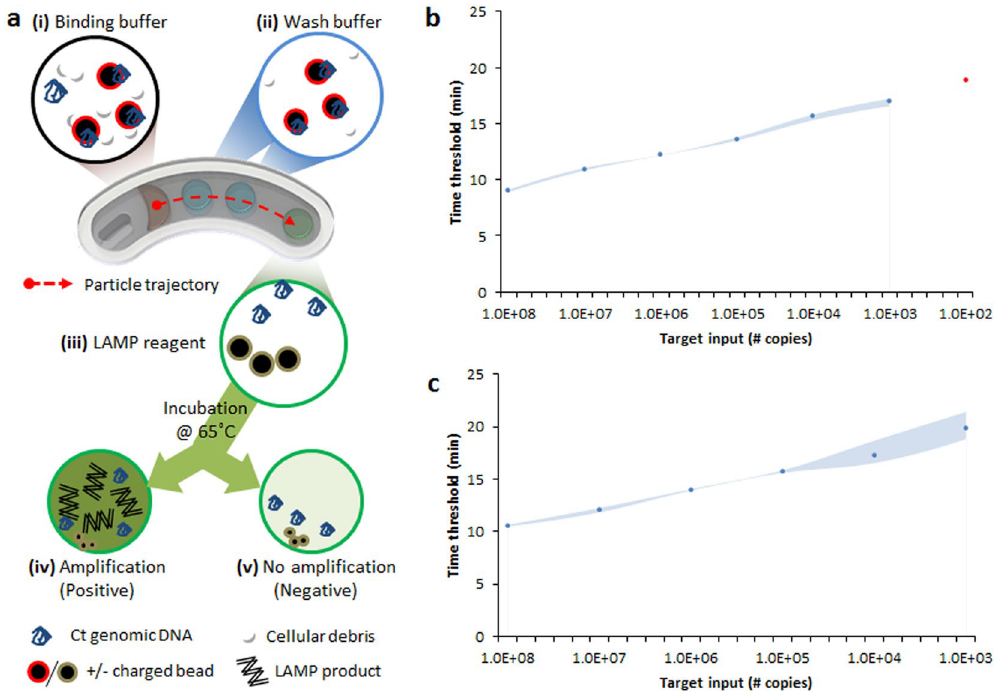
Figure 2. Assay design and sensitivity characterization. ( a ) Schematic of single-stream LAMP assay as implemented on the mobiNAAT platform. Magnetic particles capture nucleic acid targets from sample lysate via electrostatic interaction, where the acidic pH maintained by the binding buffer (i) generates a positive charge on the polyhistidine-coated bead surface. Affinity between particles and nucleic acids is maintained at acidic pH ( < pH 5) of the wash buffers (ii), which is reversed upon entry in the LAMP amplification mixture (iii) with a basic pH of 8.5. Subsequent amplification (iv) generates a green fluorescent signal based on the complexometric indicator calcein, contrasting with unamplified reagent (v). ( b ) Comparison among amplification of dilutions of synthetic DNA spiked into reaction mixture. A fraction of the replicate reactions were amplified for 10 2 copies of molecular target input (red marker, 1/3), indicating analytical sensitivity of 10 2 –10 3 copies of molecular target. Shaded areas represent upper and lower bounds of time threshold (n = 3). ( c ) Evaluation of magnetic particle-based DNA capture, elution and subsequent amplification as a function of DNA quantity in lysis/ binding buffer. Time thresholds obtained indicate sensitivity and process efficiency that are comparable to the standard LAMP process without bead coupling. Shaded areas represent upper and lower bounds of time threshold (n =